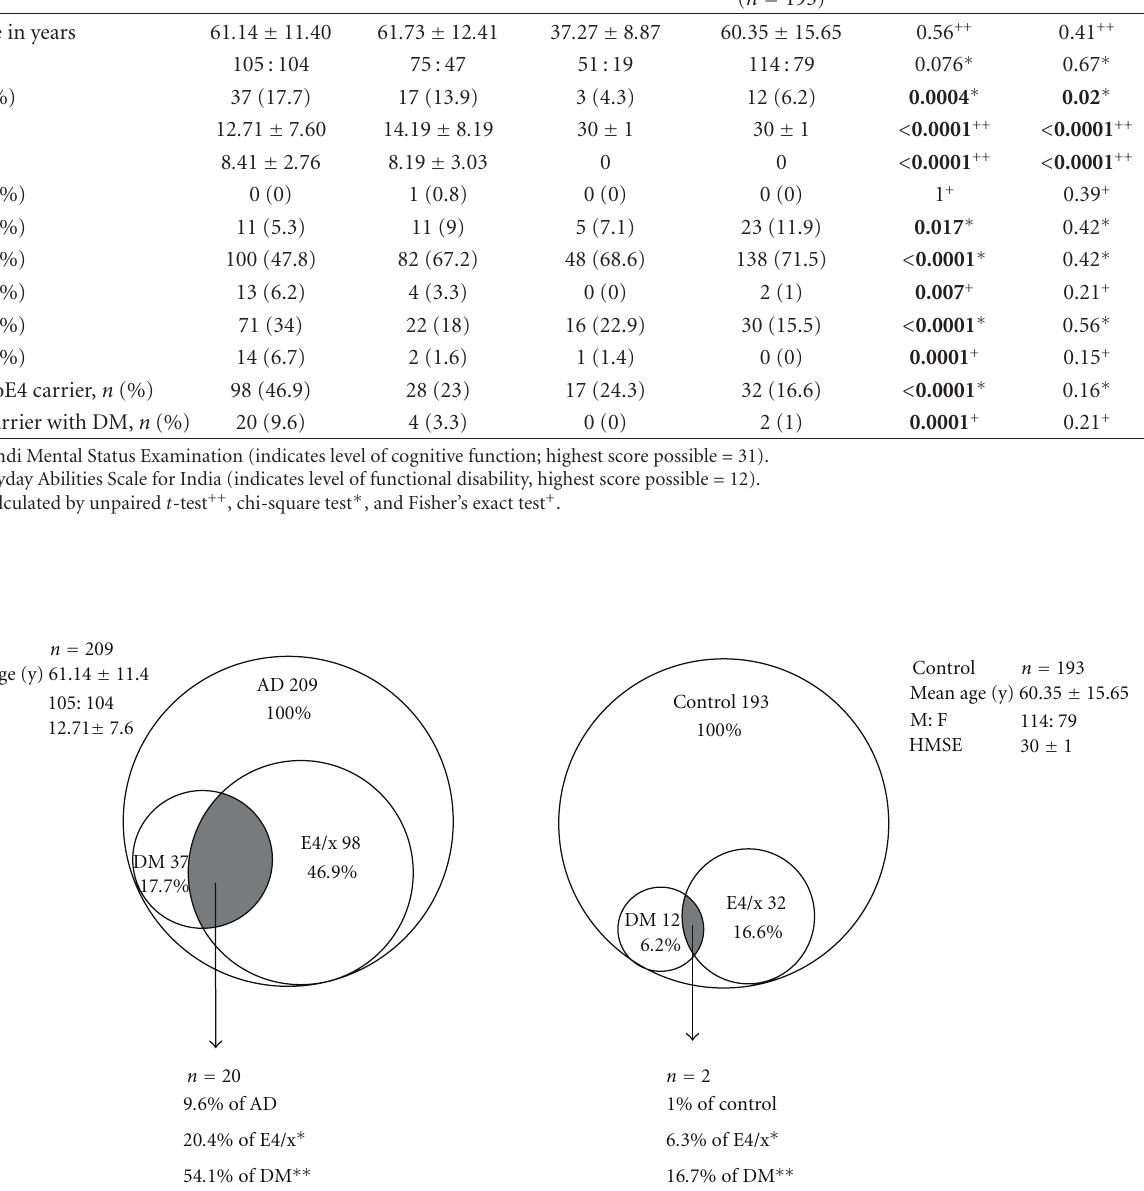
Figure 1: Venn diagram representation of AD and controls with their component distribution. Odds ratio comparing DM occurrence in ApoE4 carriers between AD and controls is 3.85 ( P = 0 . 1 ∗ ). Odds ratio comparing ApoE4-positive DM subjects between AD and controls is 5.68 ( P = 0 . 04 ∗∗